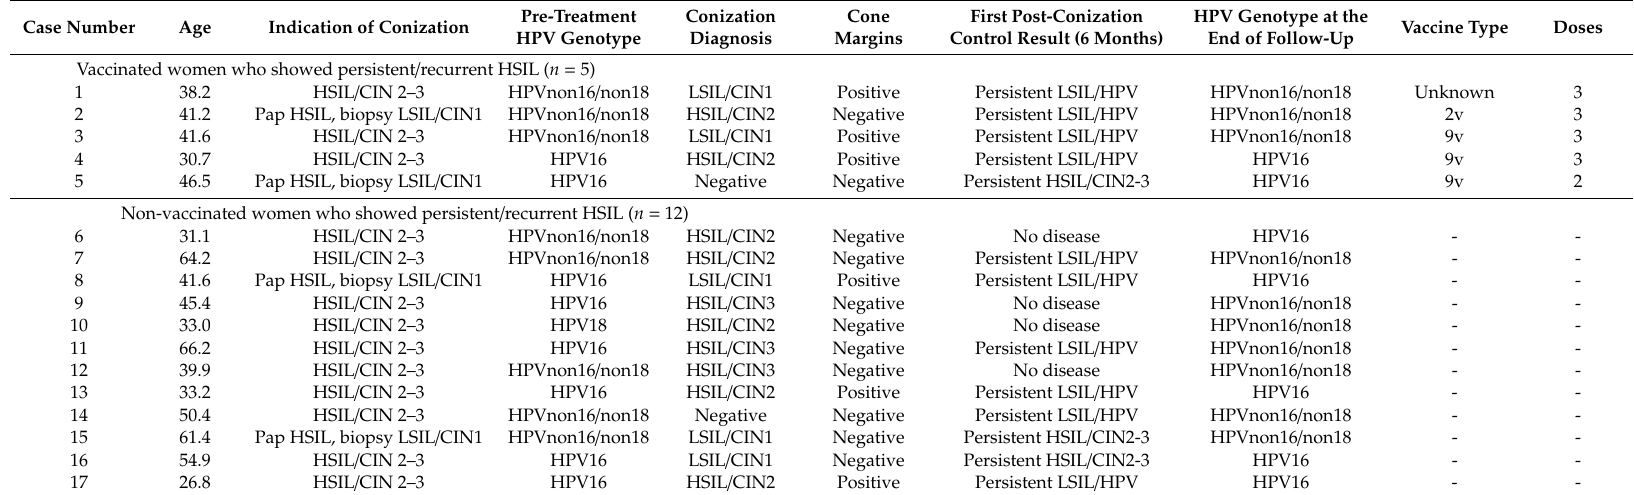
Table 2. Clinical characteristics, results at the baseline visit and of the first post-conization control performed at six months, and HPV genotype at the end of follow-up in the vaccinated and non-vaccinated women who showed persistent / recurrent HSIL at the end of